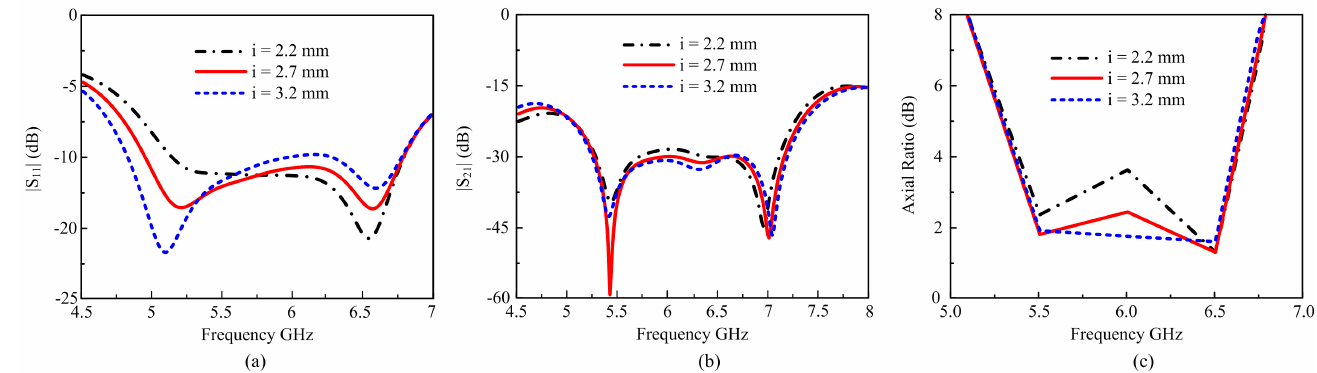
Figure 8. Simulated results for opposite square cut at square patch i: ( a ) |S 11 |; ( b ) |S 21 |; ( c ) Axial ratio.